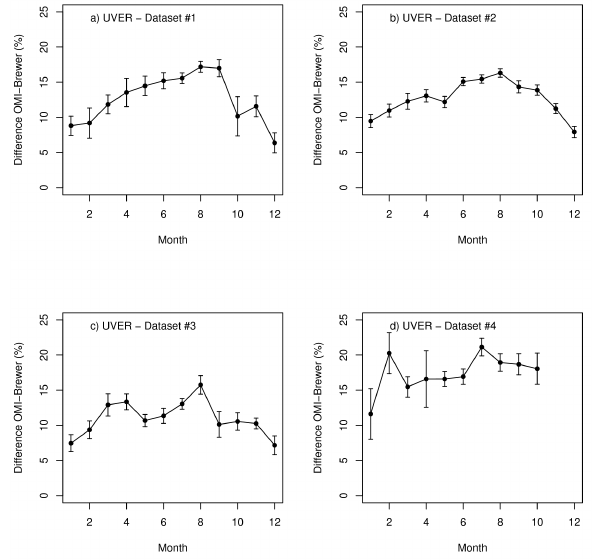
Figure 6 Fig. 6. Monthly evolution of the relative difference between OMI and Brewer UVER data for (a) all sky conditions (dataset #1); (b) for cloud-free sky condition or dataset #2 (up right); (c) dataset #3 and (d) dataset